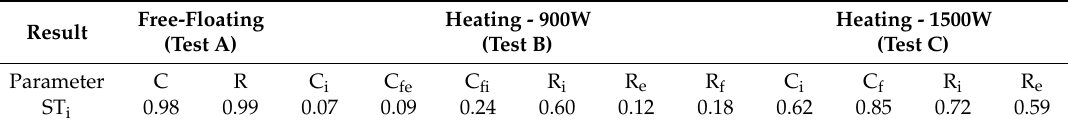
Table 3. Calculated total Sobol